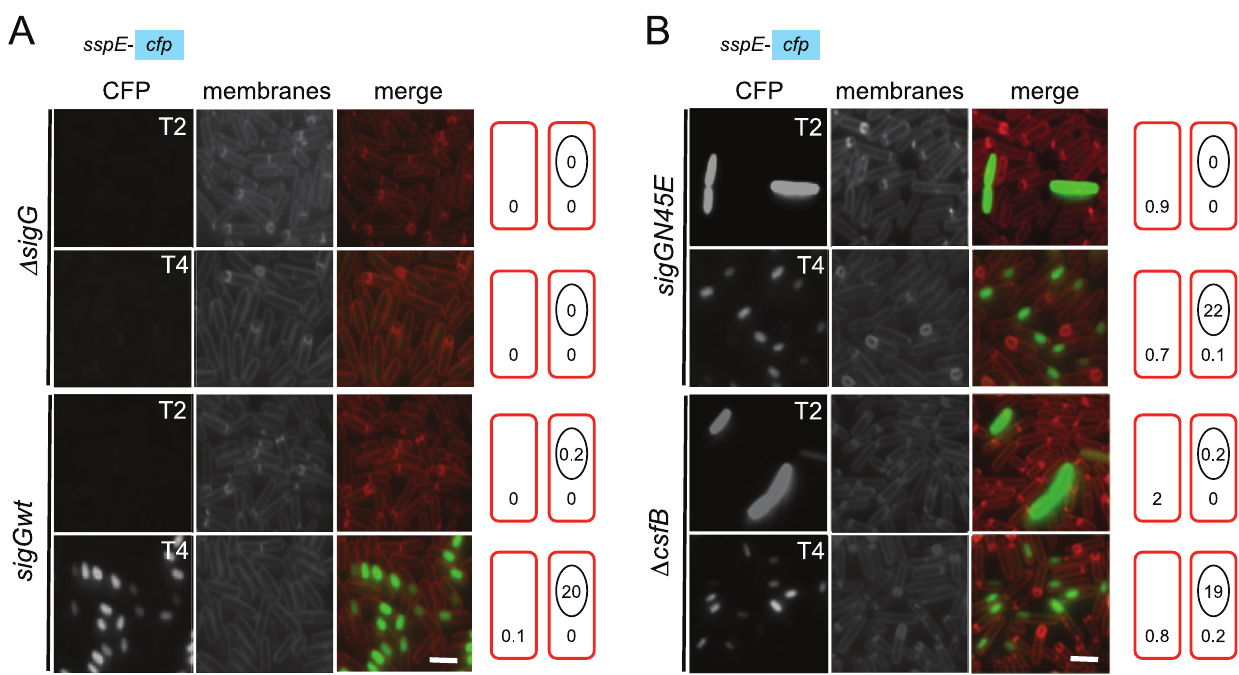
Figure 3. Localization of s G activity. The activity of s G was monitored by fluorescence microscopy 2 (T2) and 4 (T4) hours after the onset of stationary phase in sporulation medium (DSM), for the following panel of strains (A and B), all of which carrying a fusion of the s G -controlled P sspE promoter to cfp at the non-essential yycR locus: the wild-type, a D sigG mutant, the sigGN45E mutant, and the D csfB mutant. The membranes were visualized with the lypophylic membrane dye FM4-64 which is unable to reach the forespore membranes following engulfment completion, and thus serves as a reporter of the engulfment status of the forespore. Fluorescence from P sspE -cfp was false colored in green. Scale bars, 1 mm. The cartoons represent the classes of cells showing CFP accumulation at the indicated times and the numbers, the percentage of cells with CFP fluorescence in the indicated compartment.